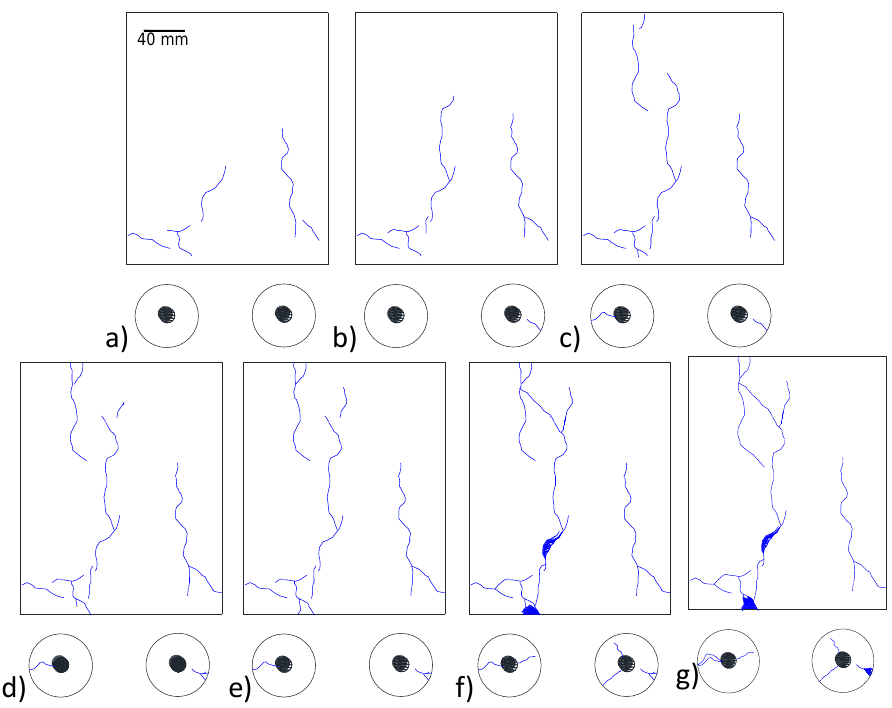
Figure 8. Crack formation due to corrosion expansion on a CaCl 2 -4 specimen of the larger batch series with a soft Metric #10 rebar at ( a ) 117 days, ( b ) 171 days, ( c ) 225 days, ( d ) 276 days, ( e ) 342 days, ( f ) 432 days and ( g ) 492 days after casting.